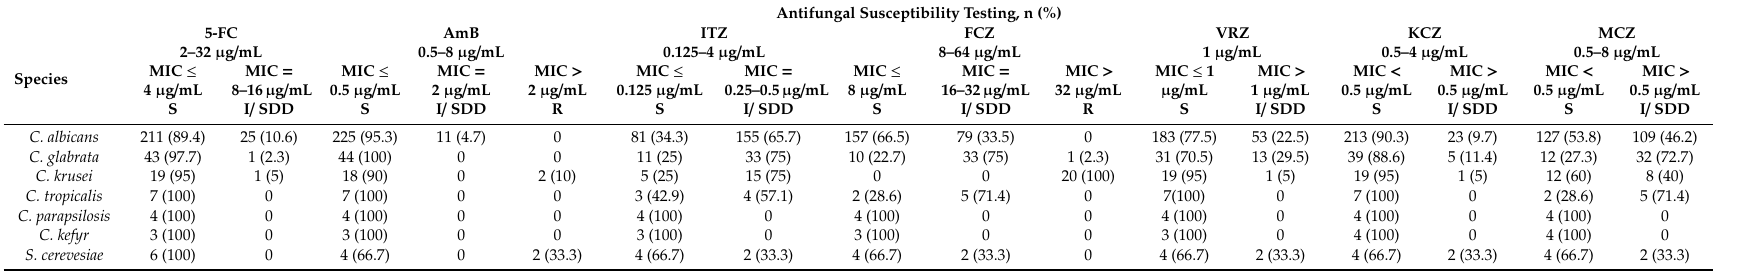
Table 2. Antifungal susceptibility testing of fungi caused RVVC obtained by Fungifast TM and Fungitest TM.